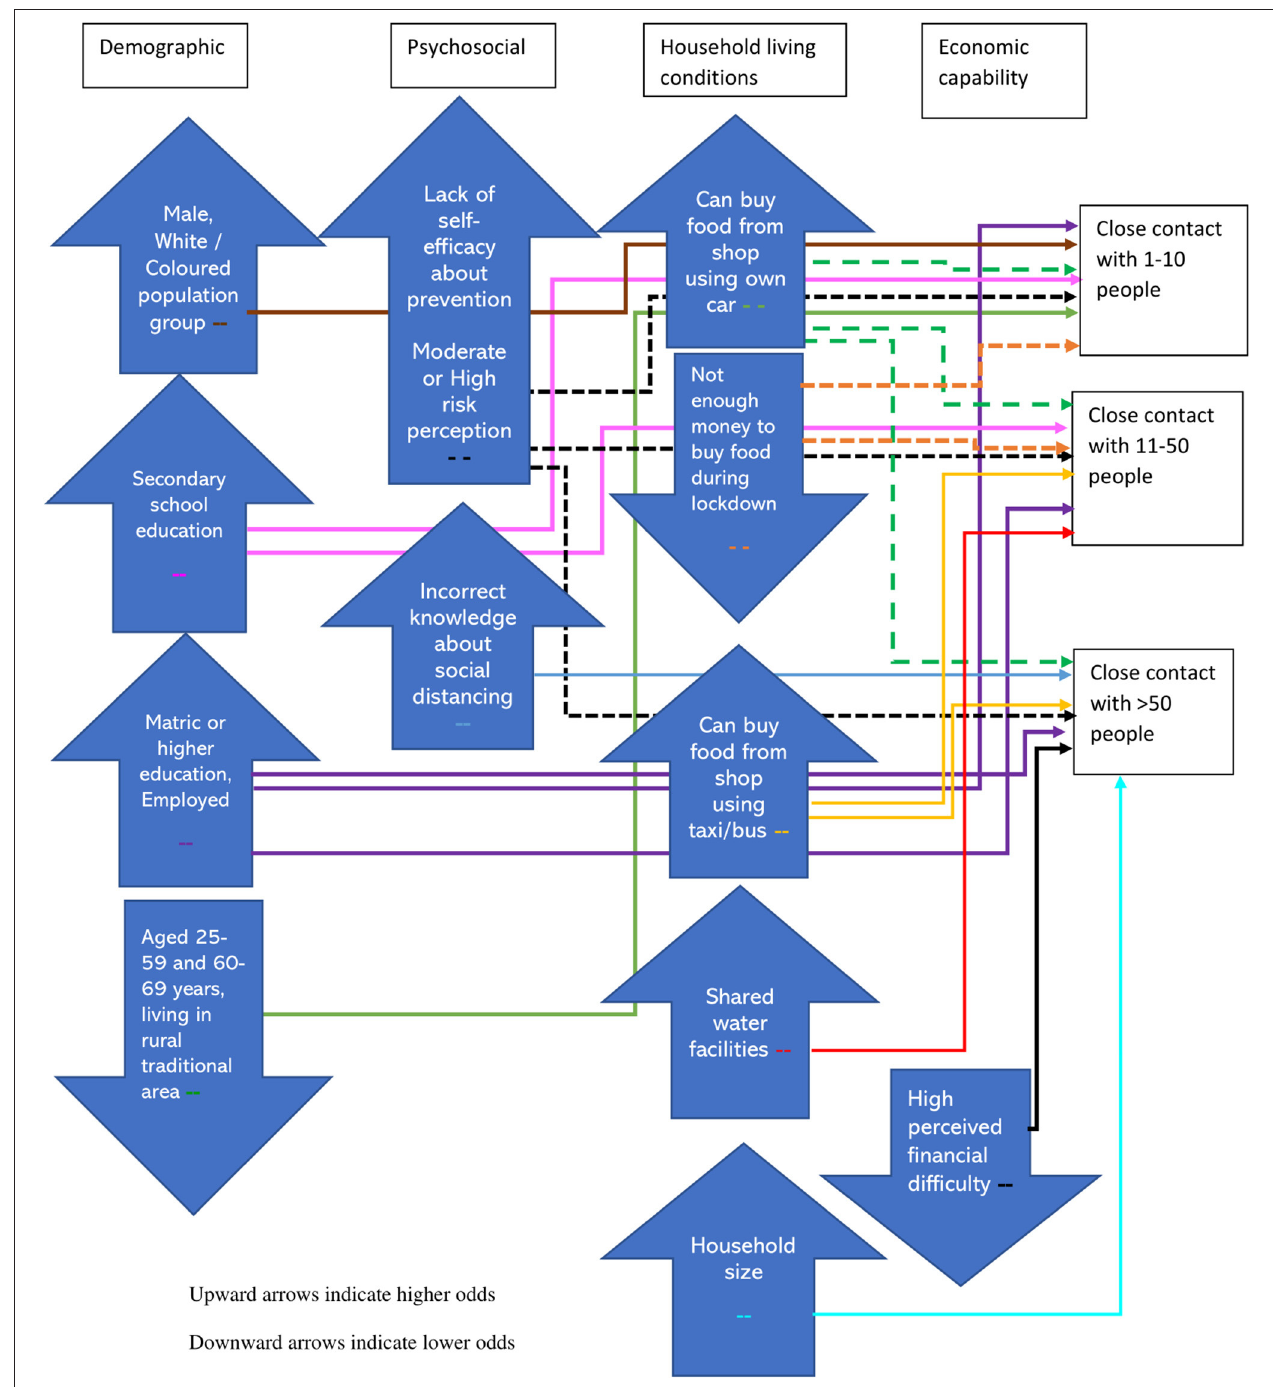
FIGURE 1 | Factors associated with higher and lower odds of 1–10, 11–50, and > 50 close contacts during the lockdown in South